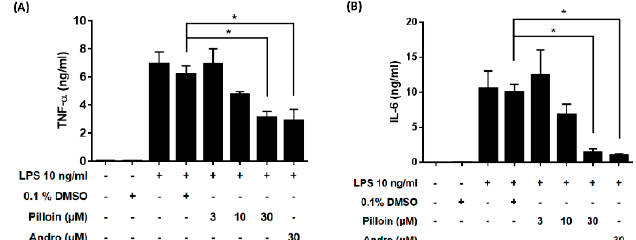
Figure 2. Pilloin suppresses the production of pro ‐ inflammatory cytokines in LPS ‐ stimulated RAW 264.7 macrophages. RAW 264.7 macrophages (2 × 10 5 in MP ‐ 96 plates) were treated with pilloin or 0.1% DMSO for 1 h, followed by LPS for 24 h. Culture medium was then assayed for ( A ) TNF ‐α and ( B ) IL ‐ 6 production using ELISA. * indicates a significant difference versus the LPS ‐ treated vehicle control ( p < 0.05).